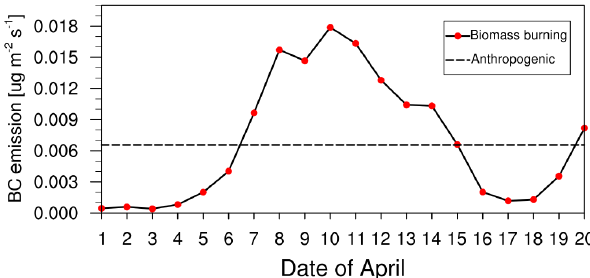
Figure 4. Time series of area-averaged daily fire emissions between 26 and 29 ◦ N over the simulation domain at 4km resolution. (The dashed line in the figure represents the anthropogenic